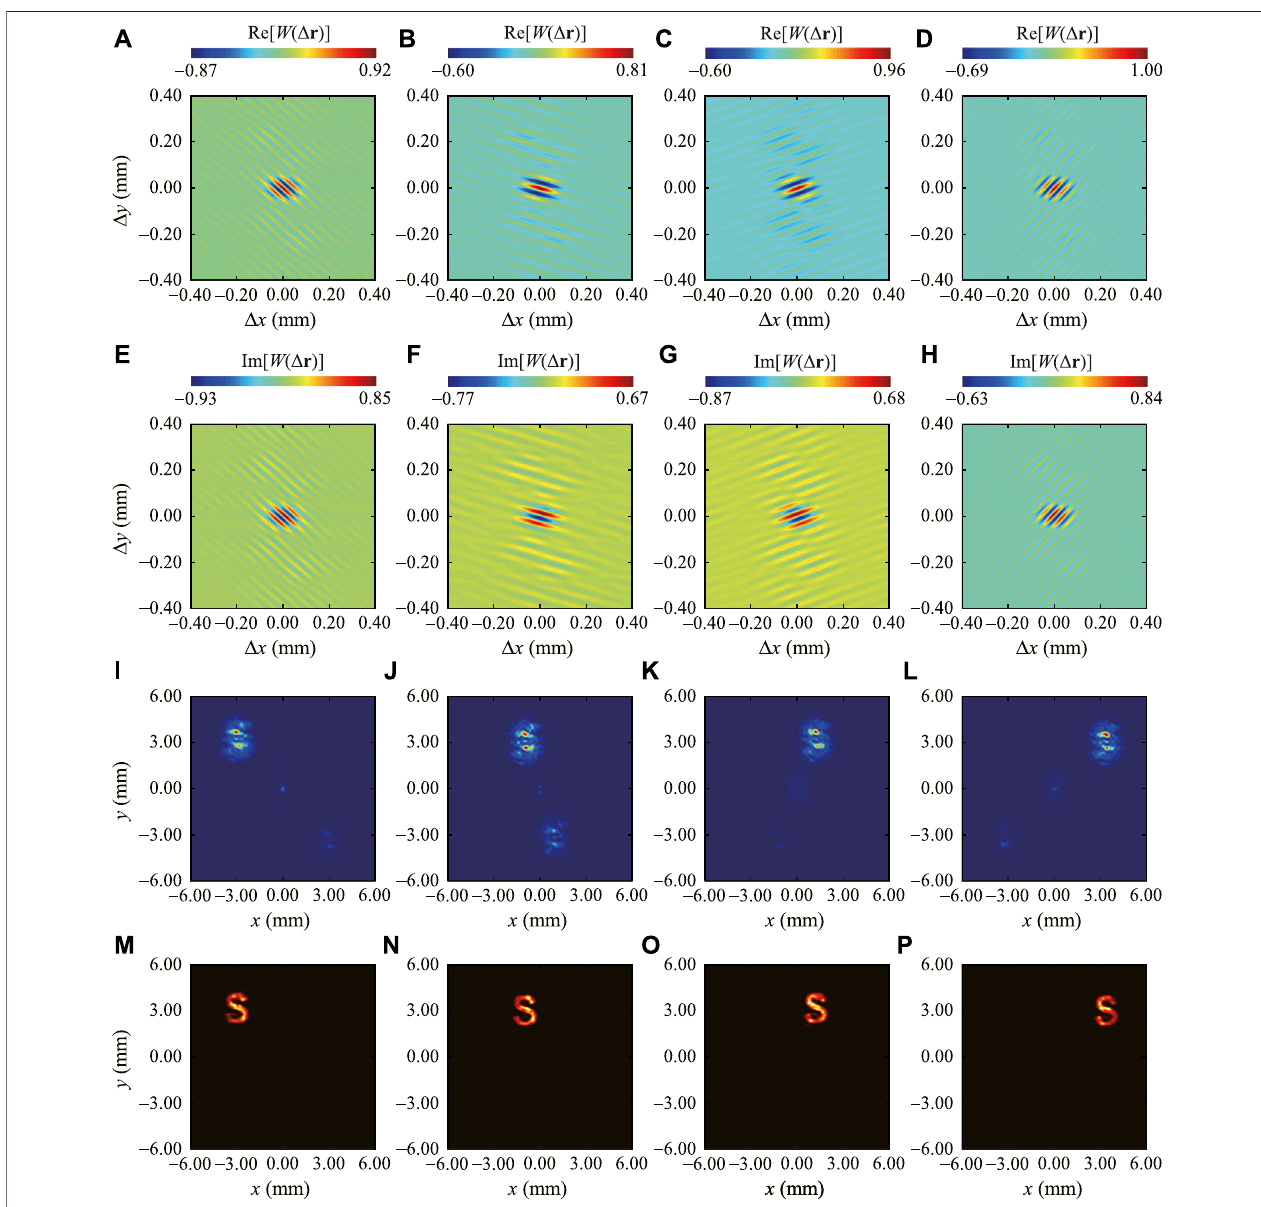
FIGURE 4 | Experimental results for the recovery of a moving image hidden behind the RGGD with complex spatial coherence structure measurement. The image moves in the transverse plane where z (cid:1) 57.5 cm. (A) – (D) and (E) – (H) The measured real and imaginary parts of the complex spatial coherence function for the cases when the image is located at different lateral positions. (I) – (L) The recovered intensities on the front surface of the RGGD. (M) – (P) The recovery images with the iterative phase retrieval algorithm.